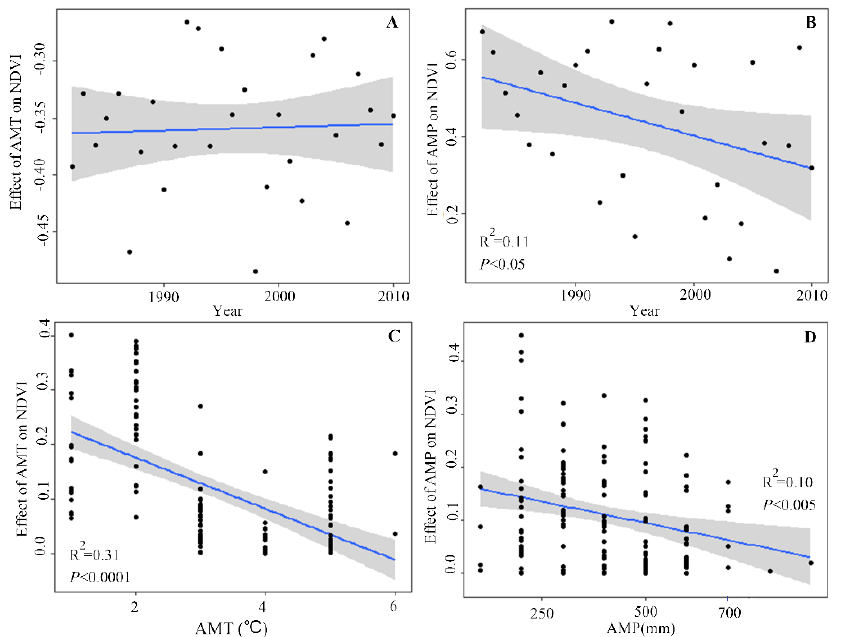
Figure 3. The dynamic effects of temperature ( A ) and precipitation ( B ) on NDVI in Inner Mongolia from 1982 to 2010. In addition, the dynamic effects of temperature ( C ) and precipitation ( D ) on NDVI across climatic gradients in Inner Mongolia. AMT, AMP, and NDVI represent the annual mean temperature, annual mean precipitation, and the normalized difference vegetation index, respectively.